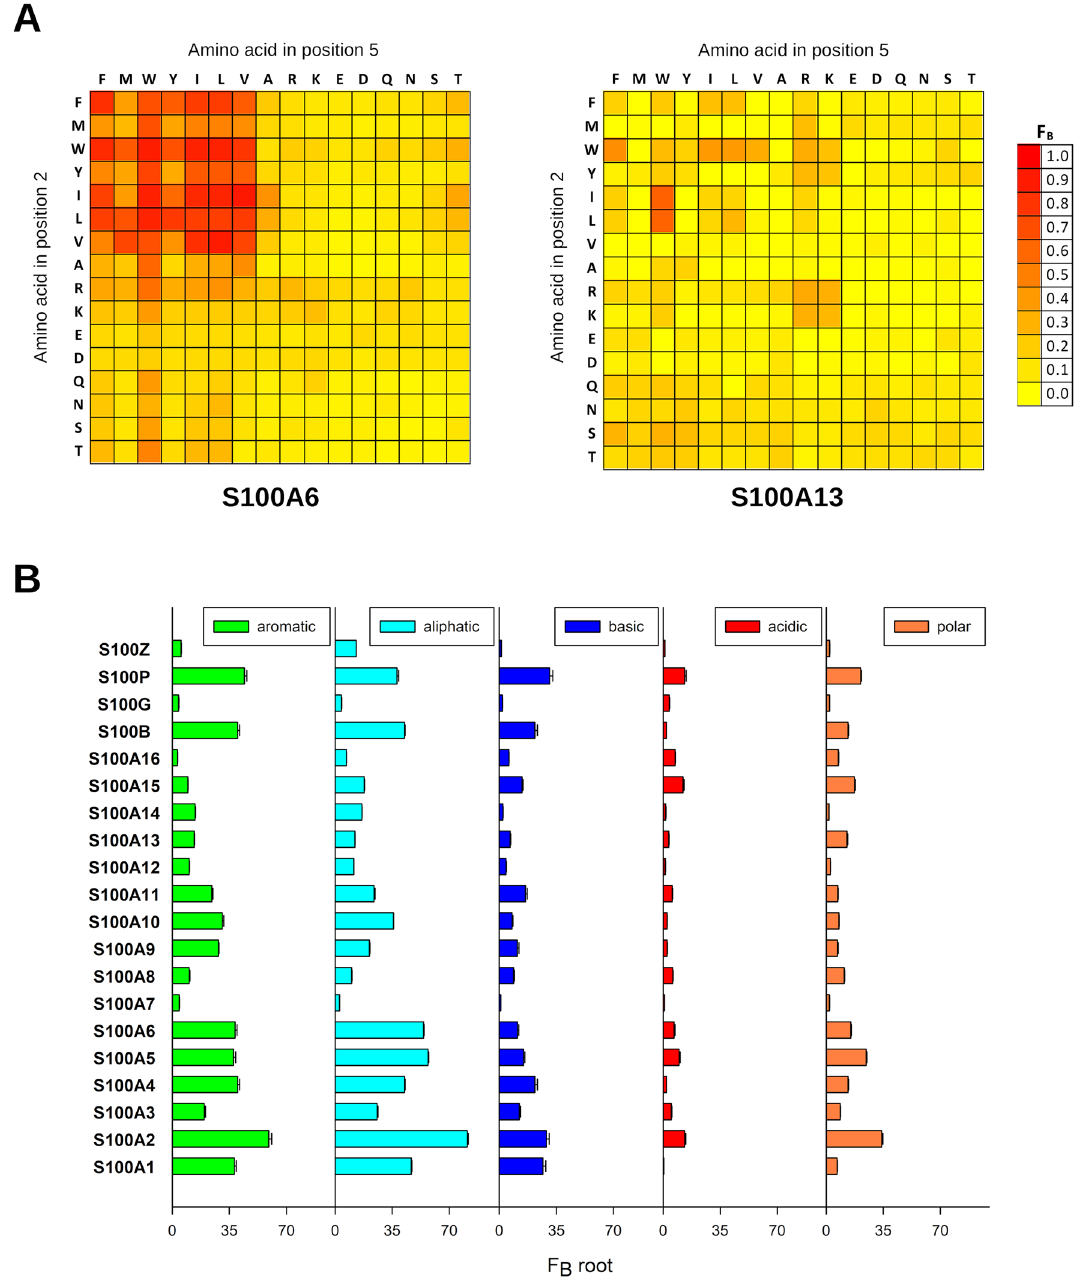
Figure 2. The interaction between the H14 foldamer library and the S100ome measured by holdup (HU) assay. (Panel A ) The interactions between S100 proteins and foldamers were measured by a high-throughput (HTP) holdup (HU) assay, as visualized in Fig. 1B. Bound fraction values were calculated based on the loss of intensity of the foldamer of interest in the flow-through fraction using Eq. (1) (see “Methods”); and were depicted as a heat map in linear scale for each S100 protein. F B ranges are color coded as shown on the right. The vertical axis and horizontal axis represents the β-amino acid in the second and fifth positions, respectively 14 . Some S100 members favored multiple fragments (e.g. S100A6 on the left), while multiple S100 proteins did not show clear binding preference towards the foldamer fragments (e.g. S100A13 on the right). (Panel B ) S100 proteins exert different amino acid sidechain preference based on the HTP HU measurements. The amino acid preferences were calculated for all S100 proteins using Eqs. (3) and (4) (see “Methods”). SEM was calculated from the three individual F Broot values. Mean ± SEM were depicted as a bar chart. The residues with high frequency in the bound foldamers have hydrophobic properties as aromatic and aliphatic side chains are the most preferred ones. Importantly, due to the rather acidic nature of S100 proteins, acidic side chains are the least preferred among S100 proteins. It is noteworthy that in some instances polar residues are also favored (e.g. S100A2,